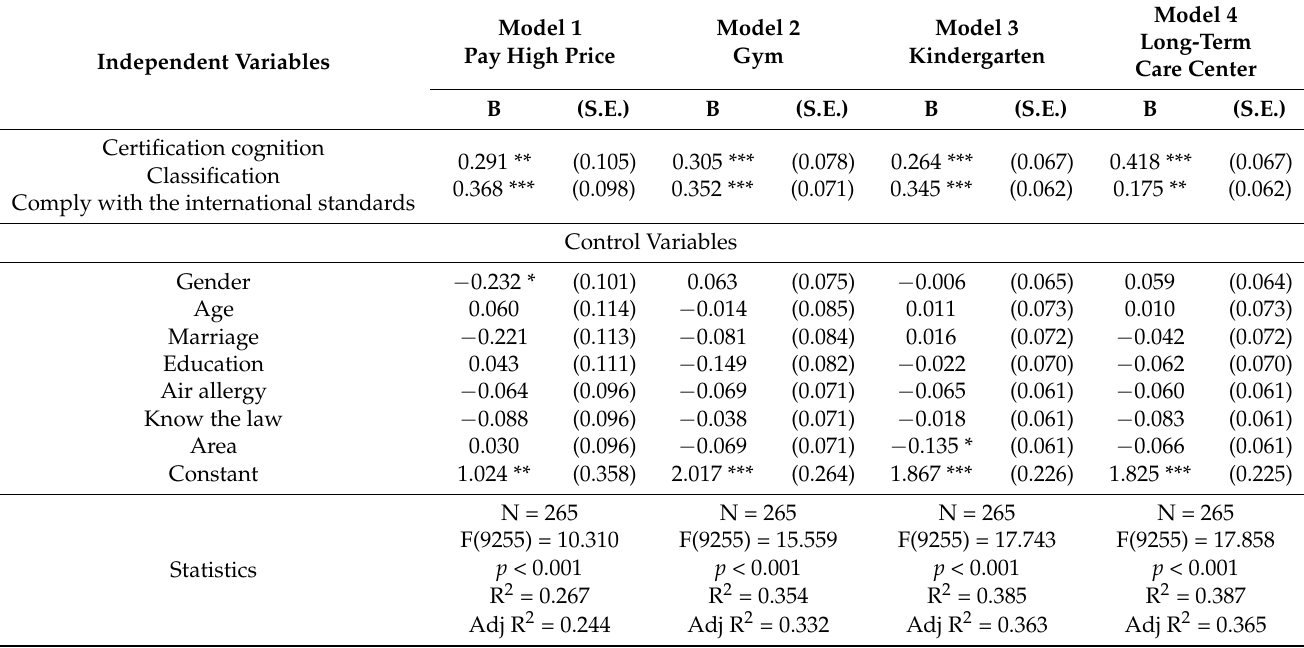
Table 9. Certification cognition